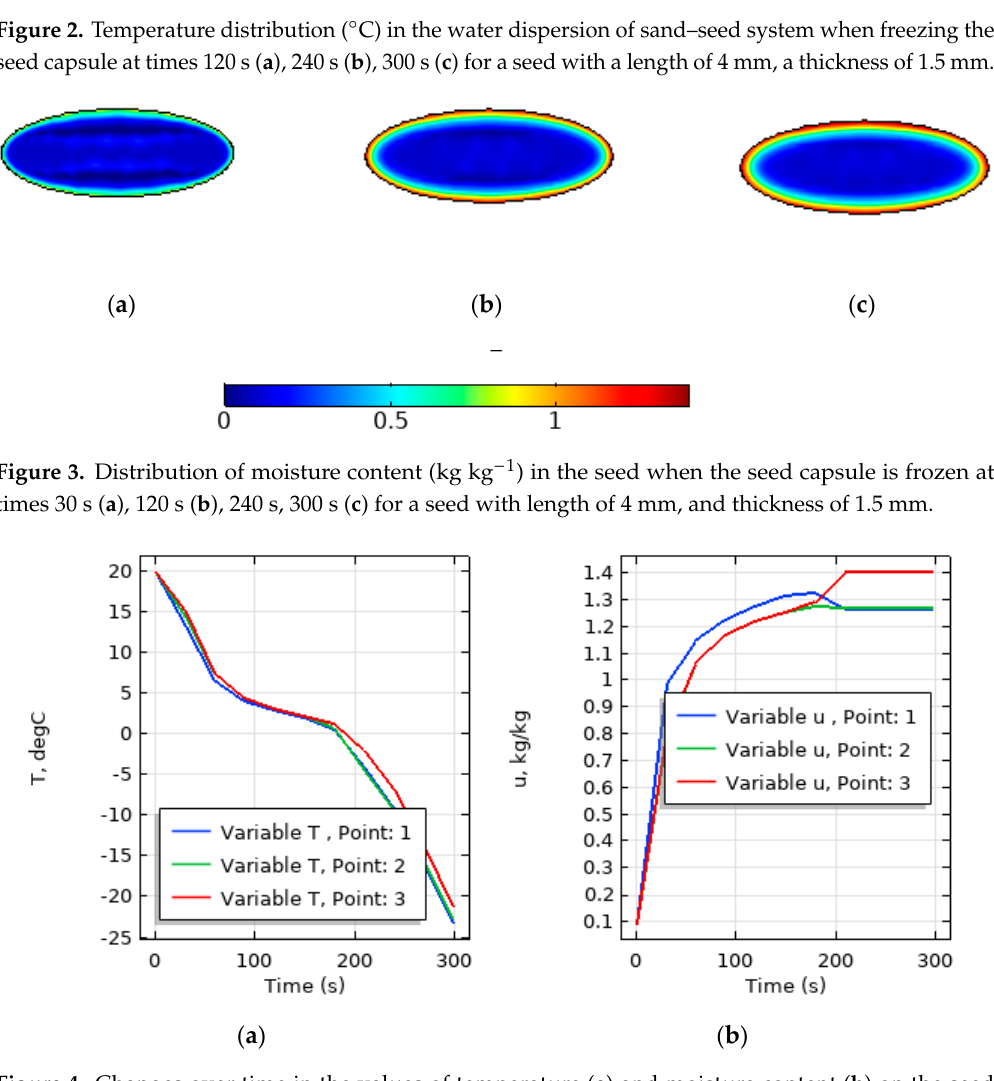
Figure 4. Changes over time in the values of temperature ( a ) and moisture content ( b ) on the seed surface at points 1, 2 and 3 marked in Figure 1b for a seed with a length of 4 mm and a thickness of 1.5 mm.